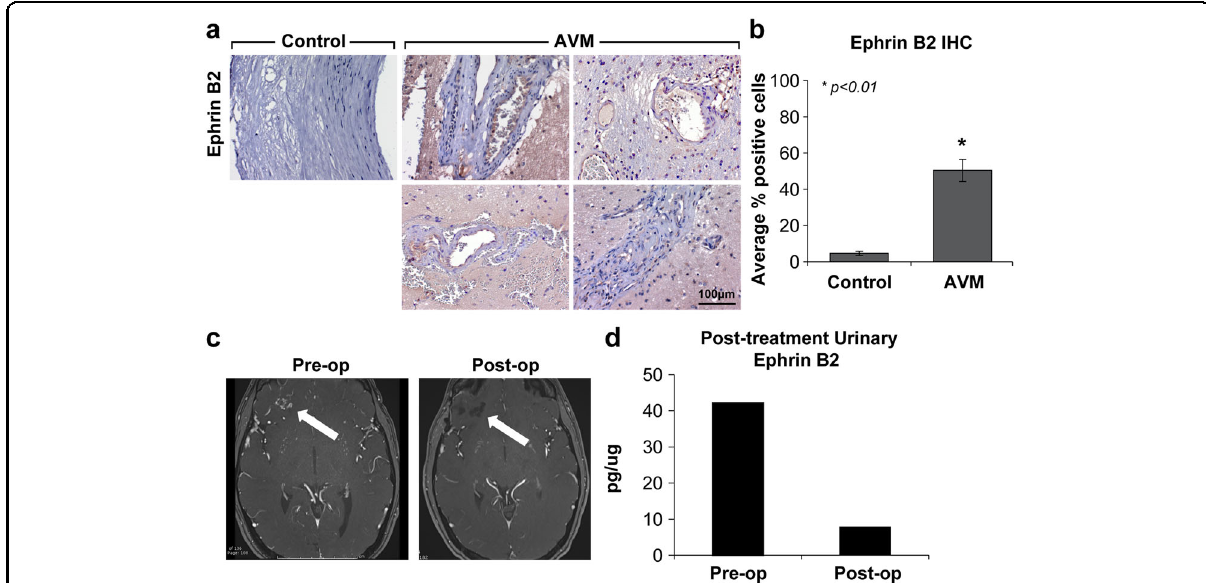
Fig. 6 Strong EphrinB2 staining in AVM tissue and normalizing levels of urinary EphrinB2 post-resection suggest AVM tissue as the biomarker source. a Representative photomicrographs show four different AVMs as con fi rmed by neuropathology. Immunohistochemical analysis identi fi es AVM as a putative source of urinary biomarker levels. EphrinB2, which localizes primarily to the arterial endothelium with scattered perinidal expression, was detected in AVM tissue at signi fi cantly higher rates than in commercially available normal arteries. Diaminobenzidine and hematoxylin counterstain, original magni fi cation ×200. b There was a tenfold increase in the number of cells with identi fi able EphrinB2 staining over a normal artery control (* p < 0.01). c Index patient for whom pre- and post-treatment analysis could be performed: preoperative MRI shows a small right frontal AVM, and postoperative MRI demonstrates a gross total resection. d At the time of diagnosis, urinary levels of EphrinB2 (>40